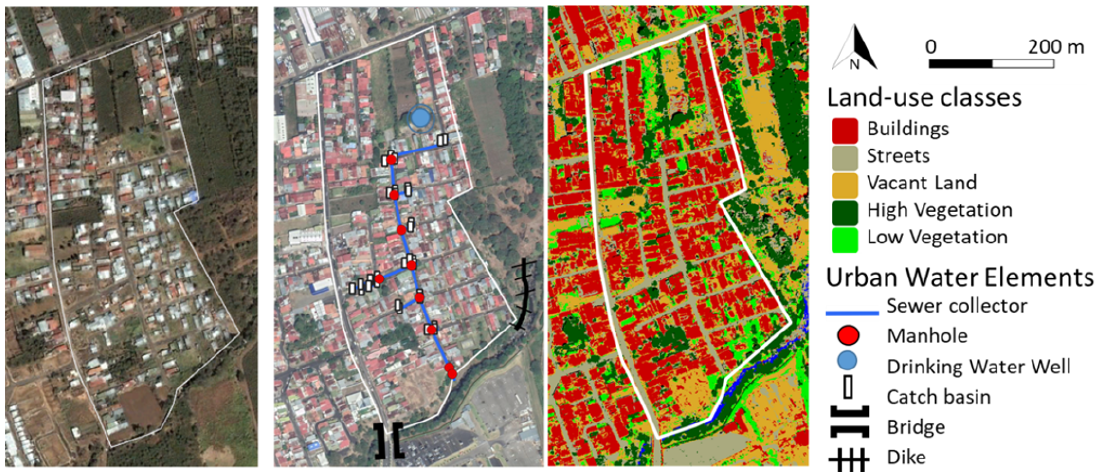
Figure 5. The area selected for implementation (white line) in the year 2003 (left), and in the year 2020 including the existing water infrastructure (middle), and the Land-Use Classification (right).